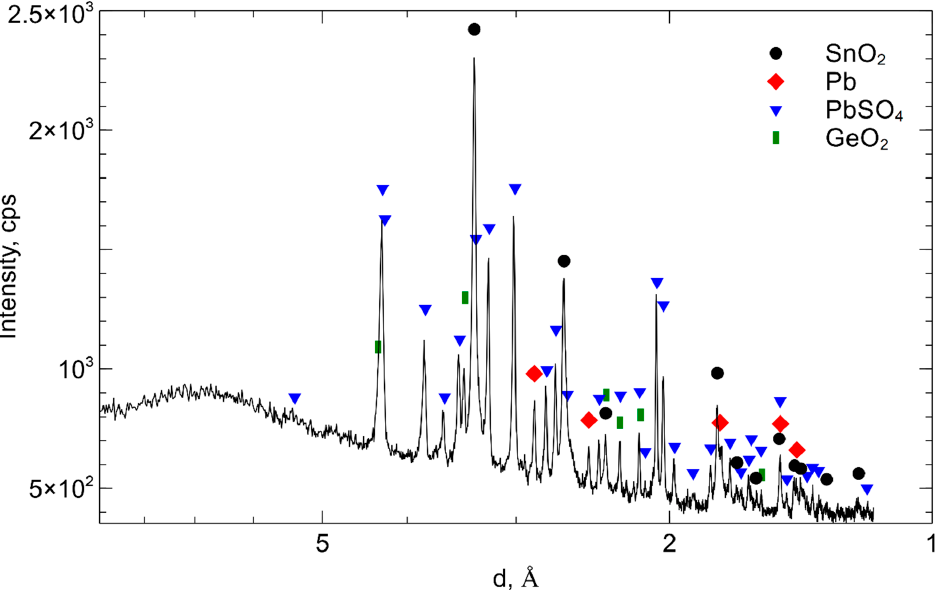
Figure 3. X-ray powder diffraction (XRD) pattern of the residue obtained from leaching of GeIn dross in sulphuric acid solution.